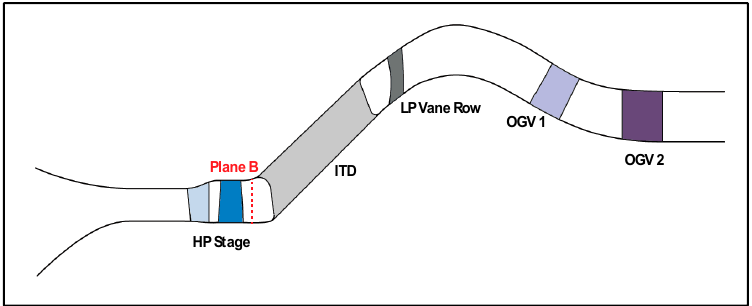
Figure 1. Schematic cross-section through transonic test turbine facility. HP: high pressure; ITD: intermediate turbine duct; LP: low pressure; OGV: outlet guide vane rows.